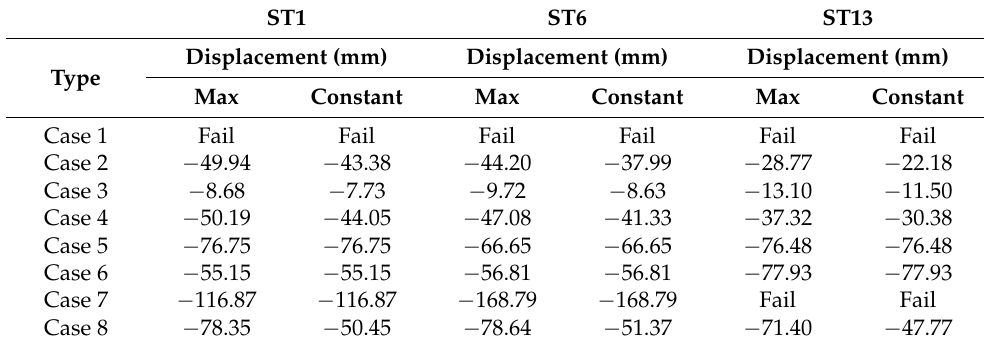
Table 2. Vertical displacement after removing a column in the stories.